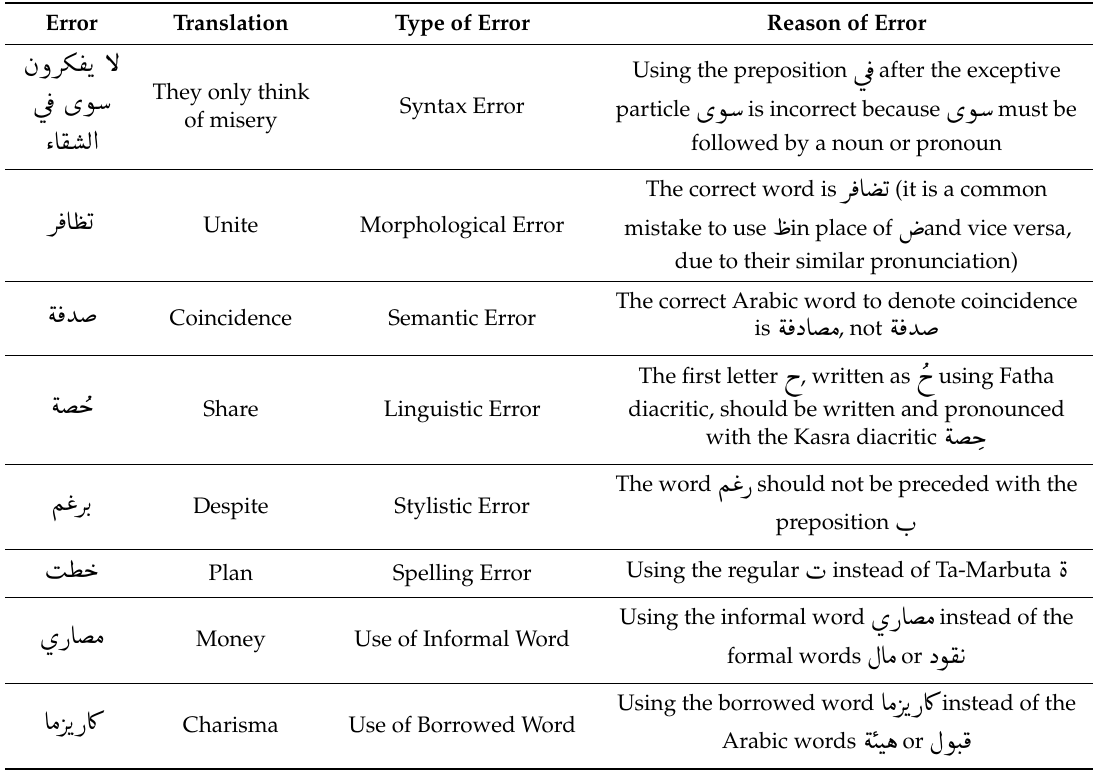
Table 1. Arabic Error